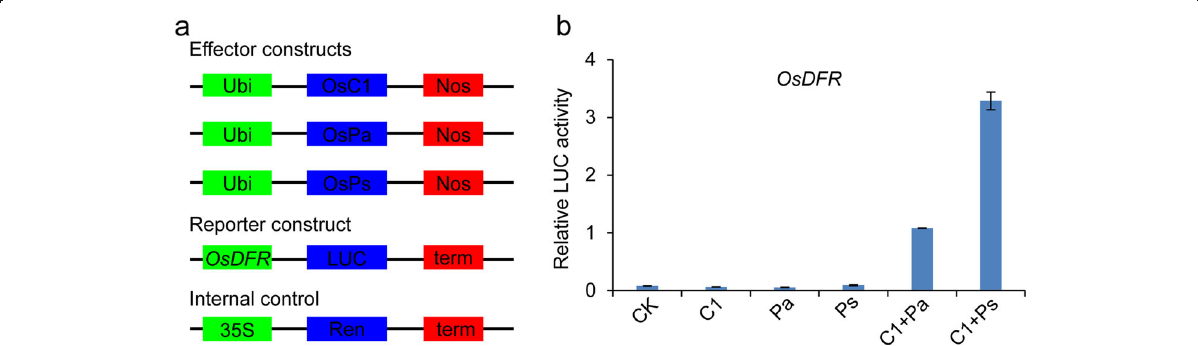
Fig. 6 Both OsC1 and OsPa or OsPs were necessary for the transcriptional expression of OsDFR promoter. a Schematic representation of the effector and reporter constructs. Full-length coding regions of OsC1 , OsPa and OsPs under control of the ubiquitin promoter were used as the effectors. Firefly luciferase gene LUC driven by the OsDFR promoters and the Renilla luciferase gene Ren driven by the 35S promoter were used as the reporter and internal control, respectively. b Transient dual-luciferase assays were performed in Nicotiana benthamiana leaves to investigate the effects of OsC1, OsPa and OsPs on the transcriptional expression of OsDFR . Relative LUC activity was measured by the ratio Firefly luciferase (LUC): Renilla luciferase (REN), and data are presented as means ± SD ( n =